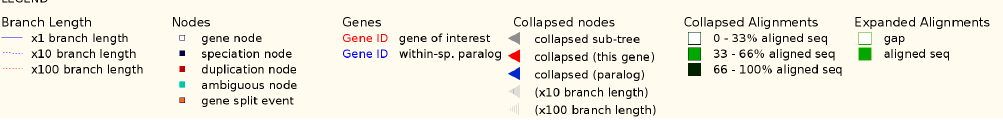
Figure 5. Gene tree for human CYP7A1 , 7B1 , 8A1/PTGIS , 8B1 , and 39A1 built using Ensembl 84. These CYP7 , 8 , and 39 family genes are paralogs to each other derived from the same ancestral gene via duplication events. The gene tree includes a total of 340 genes from various species. The total number of speciation nodes is 287, and the number of duplication is 41. The number of ambiguous nodes is 10, and there is only 1 gene split event.